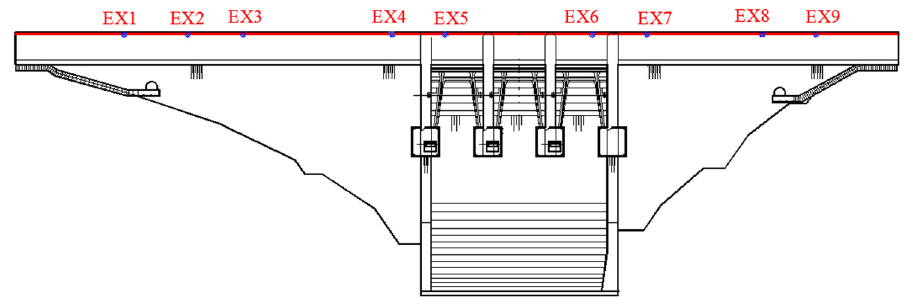
Figure 5. Dam layout plan. Table 1. Division of measuring point data set.